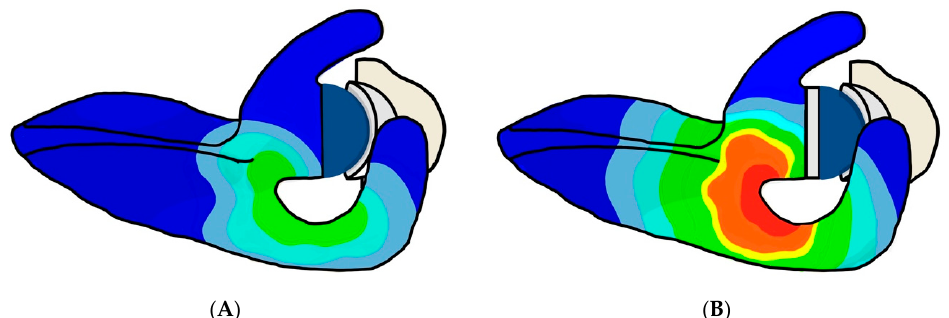
Figure 5. Illustration of the influence of glenoid component lateralization on acromial and scapular spine strain. Acromial and scapular spine strain are increased when comparing a ( A ) non-lateralized glenoid component with a ( B ) lateralized glenoid component.